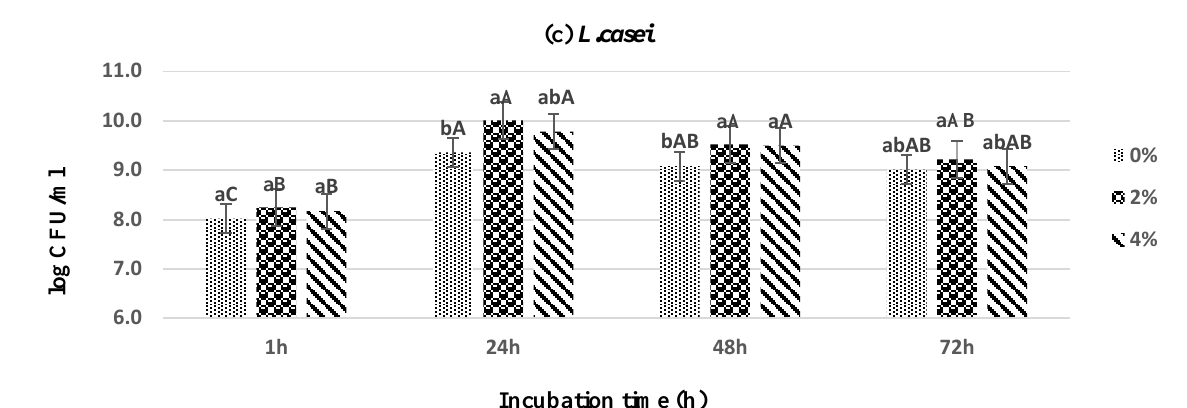
Figure 1. Prebiotic effects of different concentrations of apple peel powder (APP) on the number (log colony-forming units (CFU)/mL) of tested individual probiotic bacteria; Bifidobacterium animalis subsp. Lactis BB-12 ( a ), Lactobacillus rhamnosus (LGG) ( b ) and L. casei ( c ) during 72 h of anaerobic incubation. Different lowercase letters within each incubation time and probiotic strain indicate significant difference ( p < 0.05) based on the concentration of fruit peel powder (FPP) (0%, 2%, 4%) within same incubation time points and similar probiotic strain. Various uppercase letters indicate significant differences within the same concentrations at different incubation time points. Data represent mean values ± standard error ( n = 4).